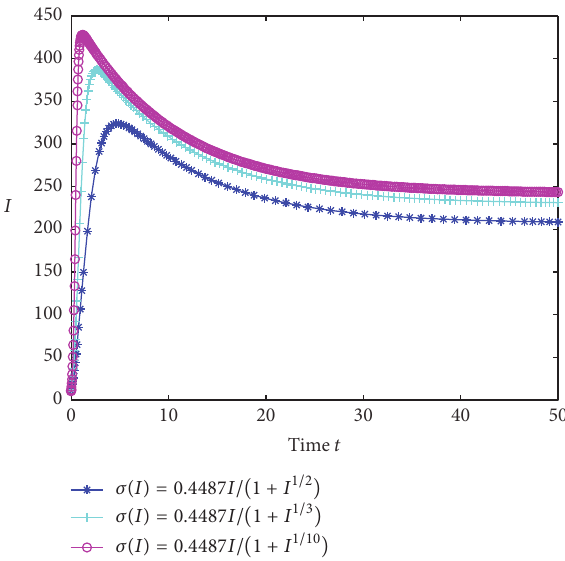
Figure 3: An illustration of the impact of 𝜎(𝐼) on 𝐼(𝑡) for system (1) given in Example